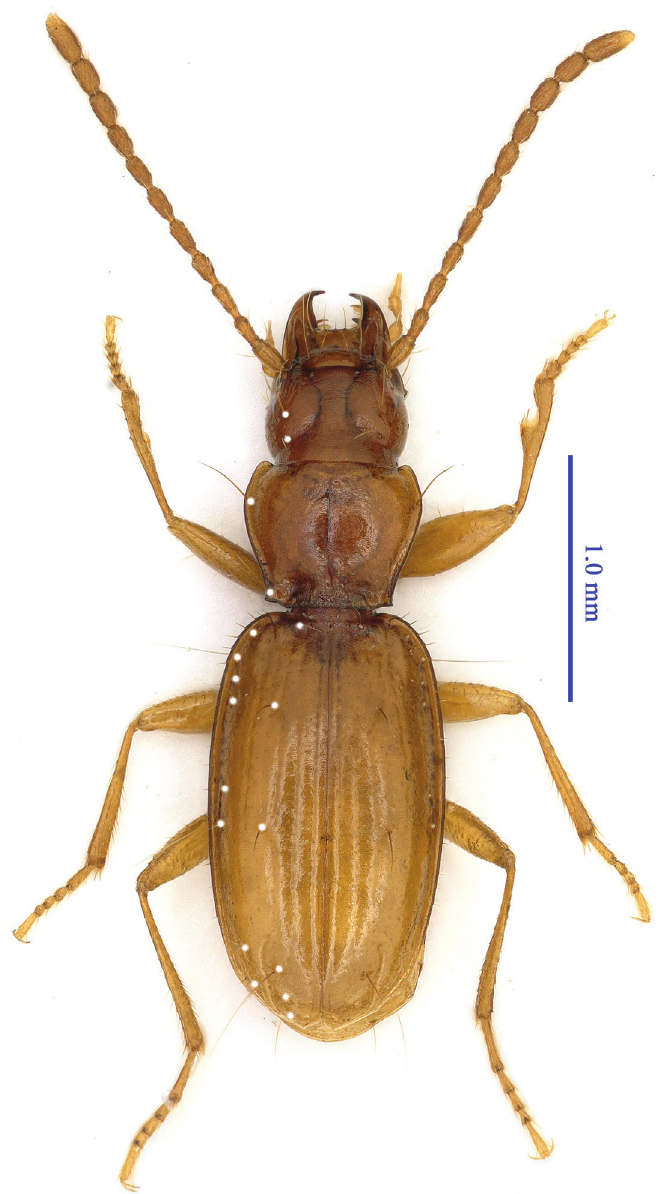
Figure 1. Habitus of Cimmeritodes ( Zhecimmerites ) parvus Tian & Li, sp. n., female, paratype. Pronotum transverse, PnL/PnW = 0.83, wider than the head, PnW/HW = 1.24, shorter than the head (including mandibles), HLm/PnL = 1.19, or as long as the head (excluding mandibles); disc moderately convex; pronotum widest at about 1/3 from the apex, fore and hind lateromarginal setae located just before the widest point